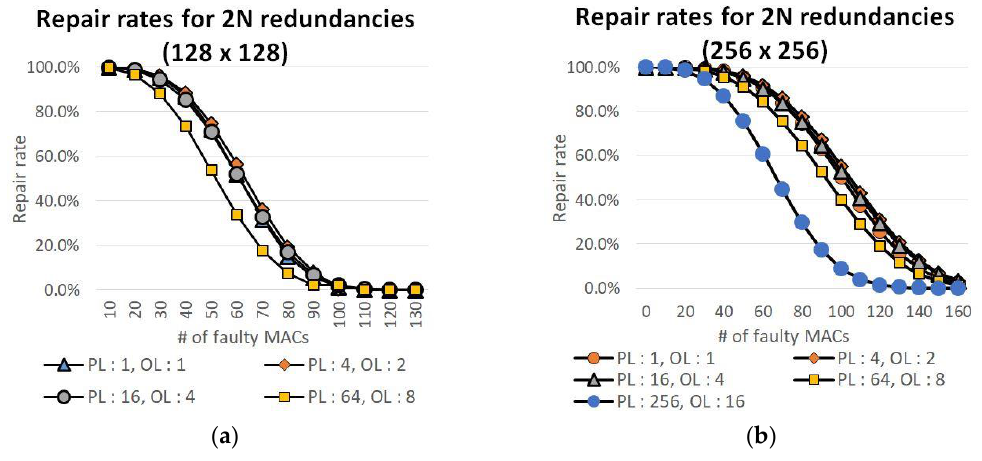
Figure 9. Repair rate comparison with 2 N redundancies: ( a ) 128 × 128; ( b ) 256 × 256. For comparison with the previous architecture [12], the experiments with the number of redundancies is set to N are conducted. Since the previous architecture places redundancy only on its right side, the number of redundancies in this architecture of N × N is determined as N . As can be seen in Table 1, even with the same number of redundancies, the redundancy architecture where redundancies on the right and bottom side has a much higher repair rate than that of the previous architecture under the condition that N is 128, 256, and 512. In addition, it can be seen that, even in this case, as PL and OL increase, the repair rate decreases slightly even if the number of redundancies is the same. Table 1. Repair rates comparison with the previous architecture (unit: %). Array size